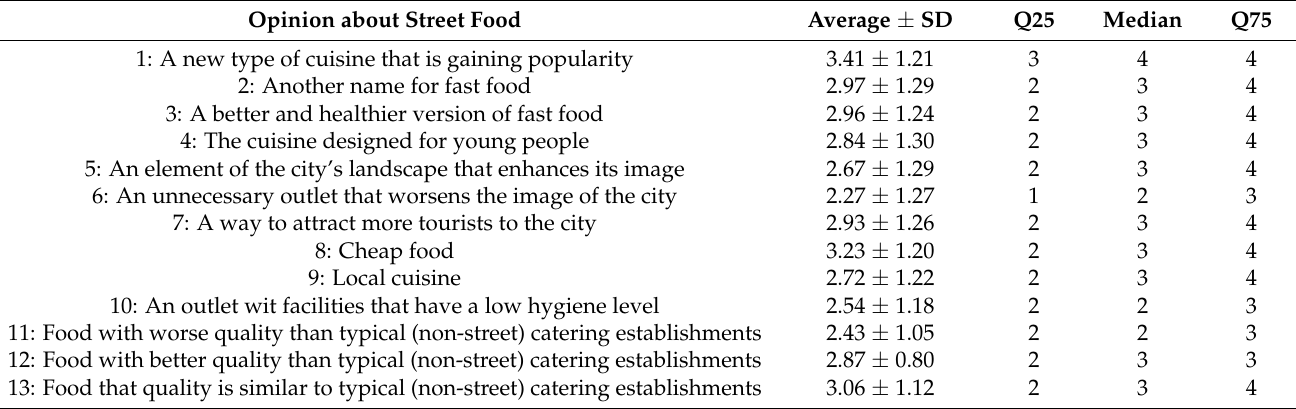
Table 3. Consumer opinion about street food